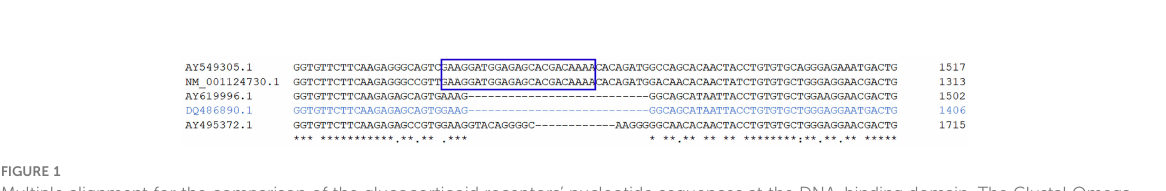
FIGURE 1 Multiple alignment for the comparison of the glucocorticoid receptors ’ nucleotide sequences at the DNA-binding domain. The Clustal Omega analysis includes the glucocorticoid receptors sequences for rainbow trout ( Oncorhynchus mykiss ) [NM_001124730.1: de fi ned by several reports as glucocorticoid receptor (Ducouret et al., 1995), glucocorticoid receptor with insert (Takeo et al., 1996), as well as glucocorticoid receptor 1 (Becker et al., 2008), supported by nucleotide database (NCBI)]; and the AY495372.1: de fi ned by several reports as glucocorticoid receptor 2 (Bury et al., 2003; Becker et al., 2008), supported by nucleotide database (NCBI)]; sea bass ( Dicentrarchus labrax ) [AY549305.1: de fi ned by Terova et al. (Terova et al., 2005) as glucocorticoid receptor; AY619996.1: de fi ned by Vizzini et al. (Vizzini et al., 2007) as “ Dicentrarchus labrax glucocorticoid receptor 1 (DlGR1)]; and sea bream [DQ486890.1: de fi ned by Acerete et al. (2007) as glucocorticoid receptor, or glucocorticoid receptor 1 by Tsalafouta et al. (Tsalafouta et al., 2018); sequence colored in blue]. The Nucleotide accession number (NCBI) is detailed on the left of each sequence. The blue box represents the forward primer designed into the conserved 27-nucleotide insertion at the DNA-binding region for identifying the sea bream glucocorticoid receptor 1 by PCR. The "*" (asterisk) indicates positions which have a single, fully conserved residue. The ":" (colon) indicates conservation between groups of strongly similar properties. The "." (period) indicates conservation between groups of weakly similar